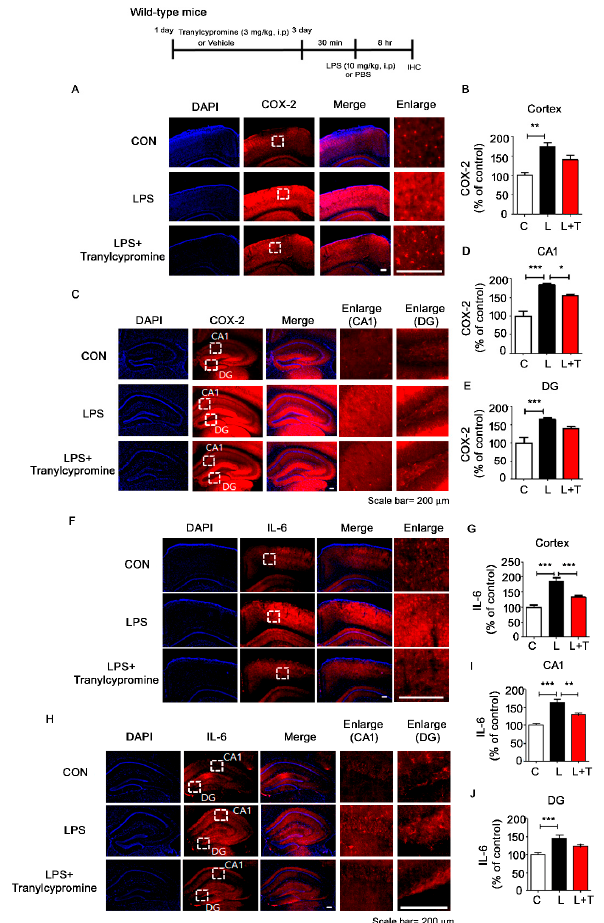
Figure 5. Tranylcypromine decreases LPS-mediated proinflammatory cytokine COX-2 and IL-6 levels in wild-type mice. ( A , C , F , H ) After daily injection with tranylcypromine (3 mg/kg, i.p.) or PBS for 3 days, wild-type mice were injected with LPS (10 mg/kg, i.p.) or PBS. Perfused and fixed mice were then subjected to immunohistochemistry with anti-COX-2 or anti-IL-6 antibodies. ( B , D , E ) Quantification of data from ( A ) (cortex: con, n = 4 mice; LPS, n = 5 mice; tranylcypromine, n = 5 mice) and C (CA1 and DG: con, n = 4 mice; LPS, n = 5 mice; tranylcypromine, n = 5 mice). ( G , I , J ) Quantification of data from ( F ) (cortex: con, n = 4 mice; LPS, n = 5 mice; tranylcypromine, n = 5 mice) and ( H ) (CA1 and DG: con, n = 4 mice; LPS, n = 5 mice; tranylcypromine, n = 5 mice). * p < 0.05, ** p < 0.01, *** p < 0.001. CON and C, control; L, LPS; L + T, LPS + Tranylcypromine.